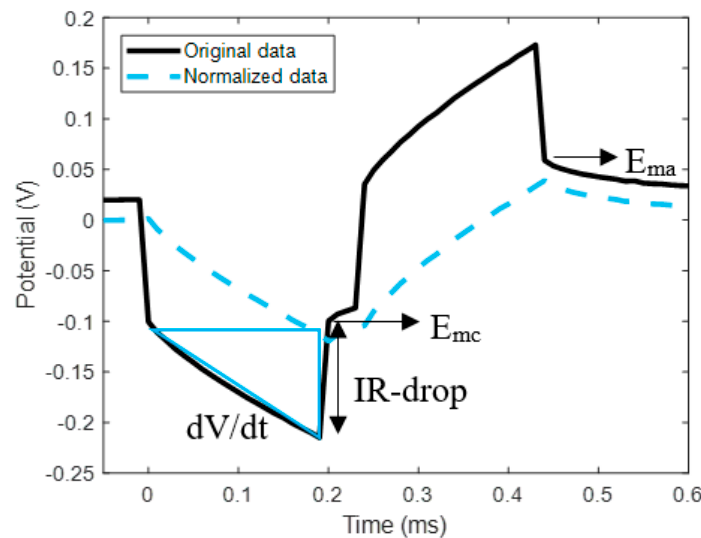
Figure 1. IR-drop, dV/dt, E mc and E ma are derived from the original data, while in the manuscript normalized data are presented. The data is normalized by subtracting the IR-drop and setting the pre-pulse potential to 0.